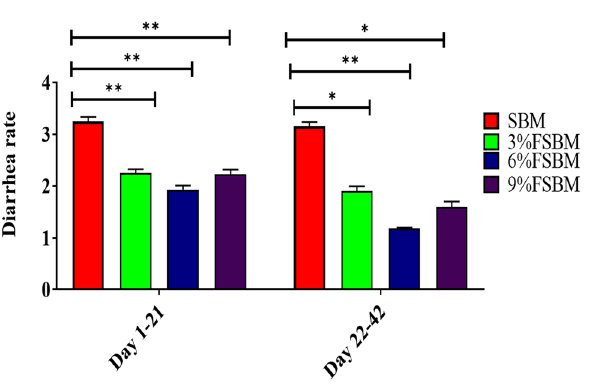
Figure 1. Effect of fermented soybean meal (FSBM) on growth performance in piglets. ( A ) Body weight (BW). ( B ) Average daily gain (ADG). ( C ) Average daily feed intake (ADFI). ( D ) Gain-to-feed ratio (G:F). Data are presented as means ± SD. * P < 0.05, ** P < 0.01. SBM, soybean meal; FSBM, fermented soybean meal.